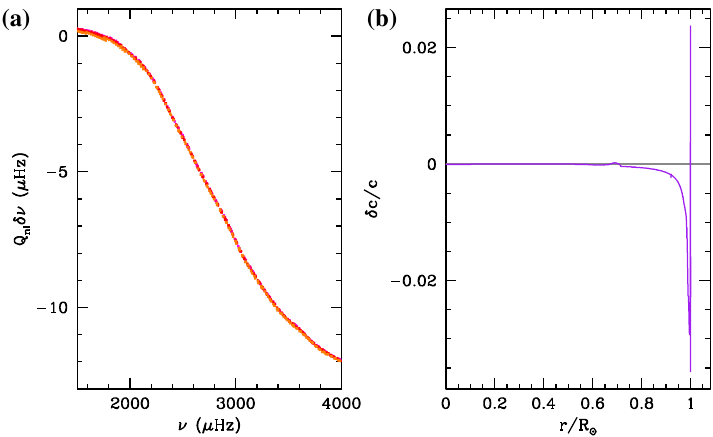
Fig. 9 a The scaled frequencies differences between a solar model constructed with the conventional mixing length treatment and one with the Canuto–Mazzitelli (CM) formulation. Only differences of modes with (cid:2) < = 50 are shown. b The relative sound-speed difference between the two models. The differences are in the sense